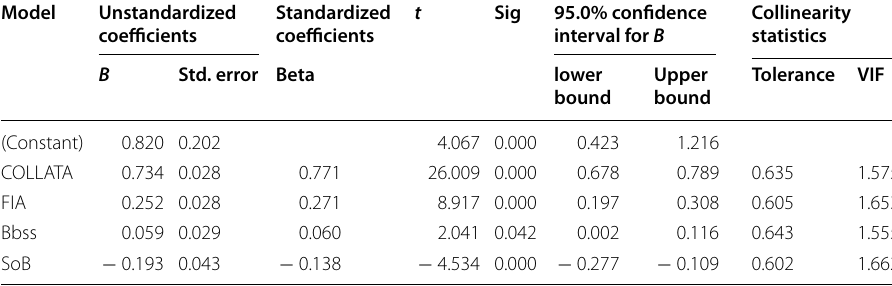
Table 5 Standardized coefficient